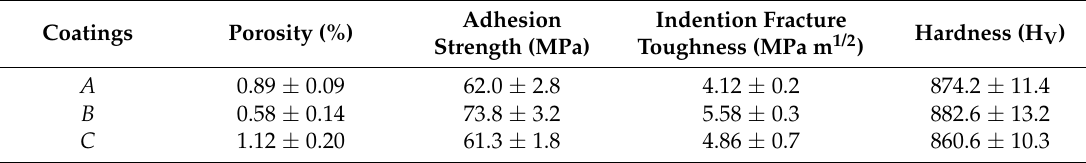
Table 2. Characteristics of the three coatings.